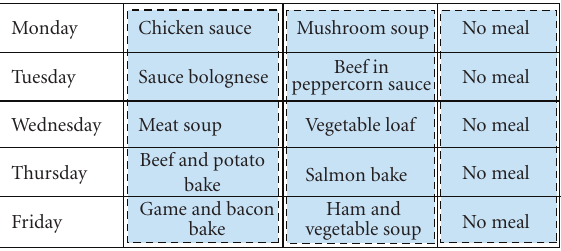
Figure 6: Meal menu with free-format tags (tags outlined with dashed